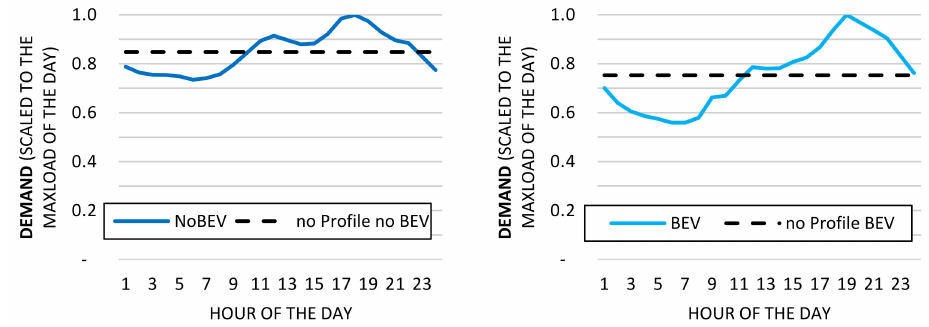
Figure 11. Exemplary depiction of the demand curves for the model runs without BEV ( left graph ) and with BEV demand ( right graph ) one time without profiles (black dashed lines) and with profiles (blue lines) for an exemplary